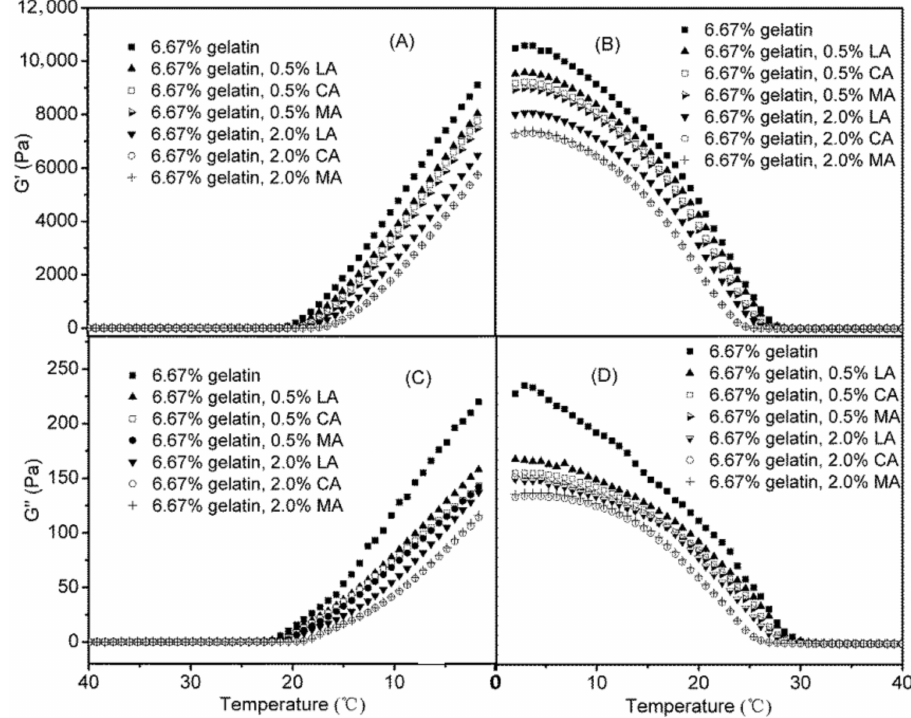
Figure 5. Changes of G (cid:48) and G (cid:48)(cid:48) of 6.67% gelatin dispersions, as affected by the addition of LA, CA and MA during the cooling ( A / C ) and heating stages( B / D